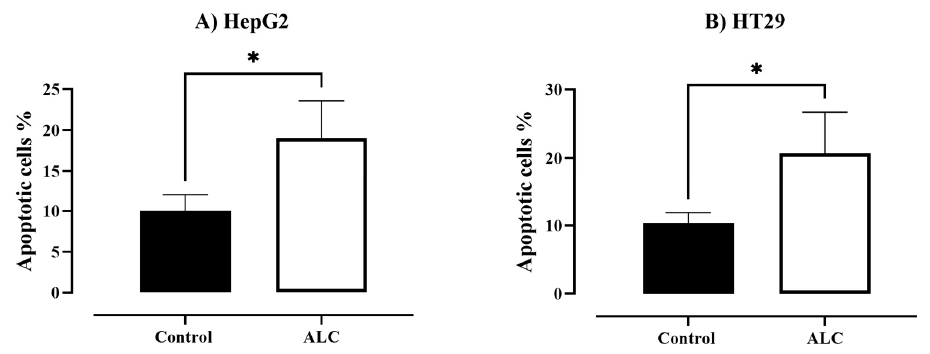
Figure 7. Apoptotic cells (%) under fluorescent microscopy in HepG2 and HT29 cells after ALC treatment compared to control. ( A ) HpG2 cells, ( B ) HT29 cells. The proportion of apoptotic cells in each cell line after the treatments were determined using inverted fluorescence microscopy. An unpaired t -test analysis was used to compare the apoptotic % between treated and control in each cell line. Data expressed as means ± SE of three experiments * p < 0.05 compared to control. 3.4. ALC Downregulates the Expression Level of Matrix Metallopeptidase 9 (MMP9) and Vascular Endothelial Growth Factor (VEGF) in HepG2 and HT29 Cell Lines To determine the effect of ALC on HepG2 and HT29 cells, the mRNA expression levels of MMP9 and VEGF were determined. The results obtained in Figure 8A,C show a significant decrease in mRNA expression levels of MMPs and VEGF in both cell lines treated with ALC ( p < 0.05) compared with the control.